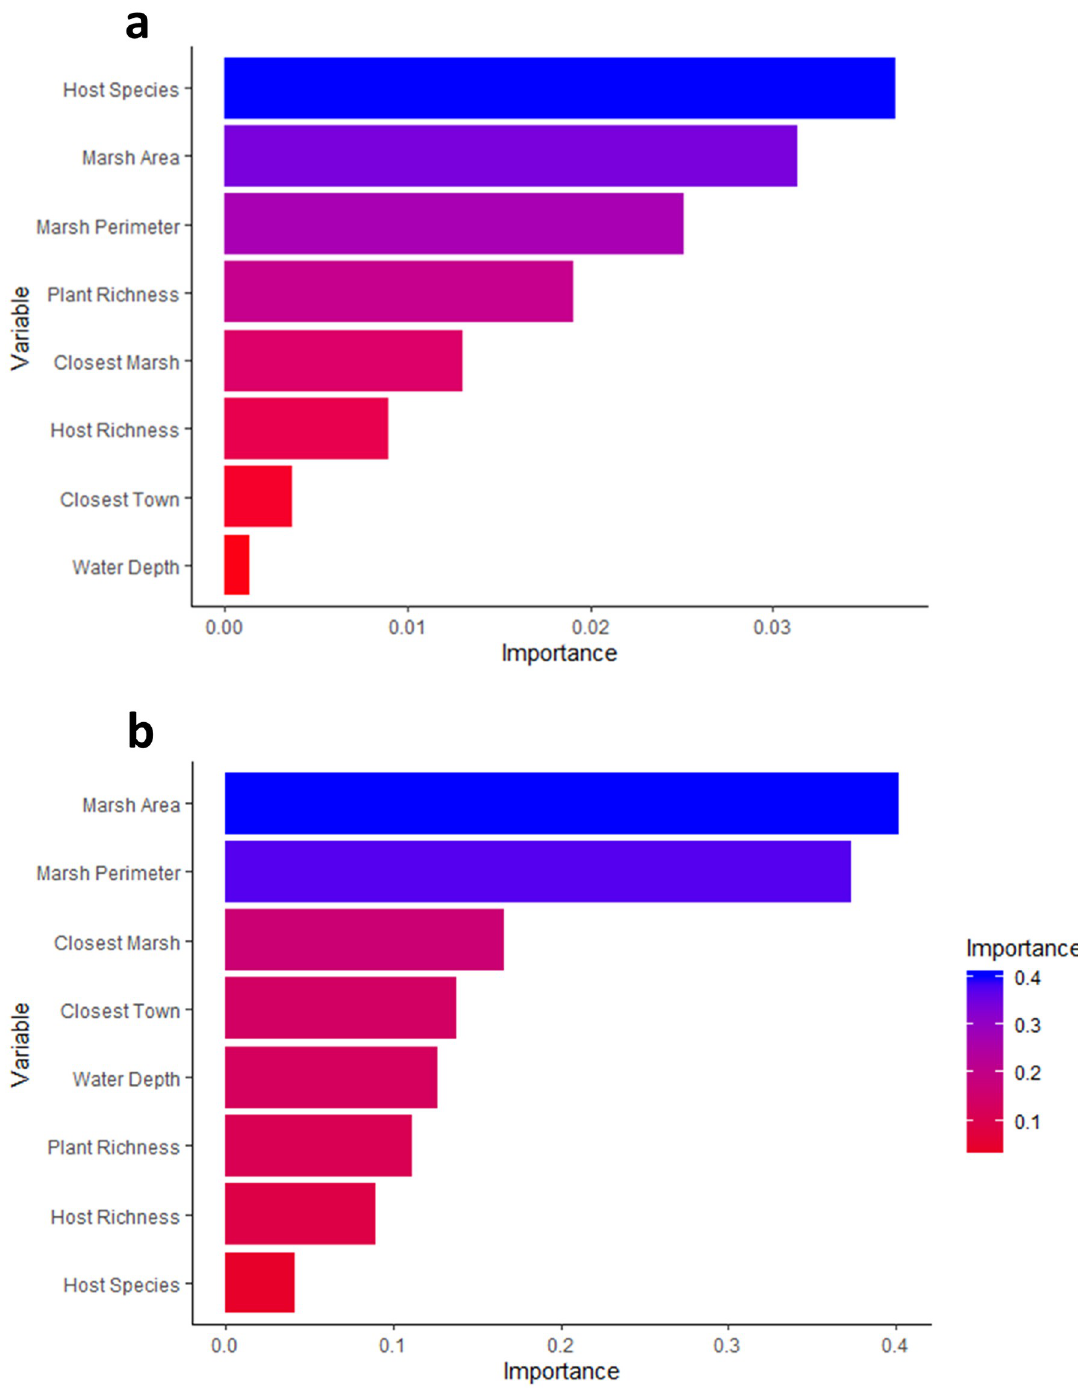
Fig 5. Multivariate random forest model and relative importance of predictor variables of ectoparasite community. Ectoparasite component communities (5a) and infracommunities (5b) of rodents from 11 marsh patches in Tecopa, California, US.